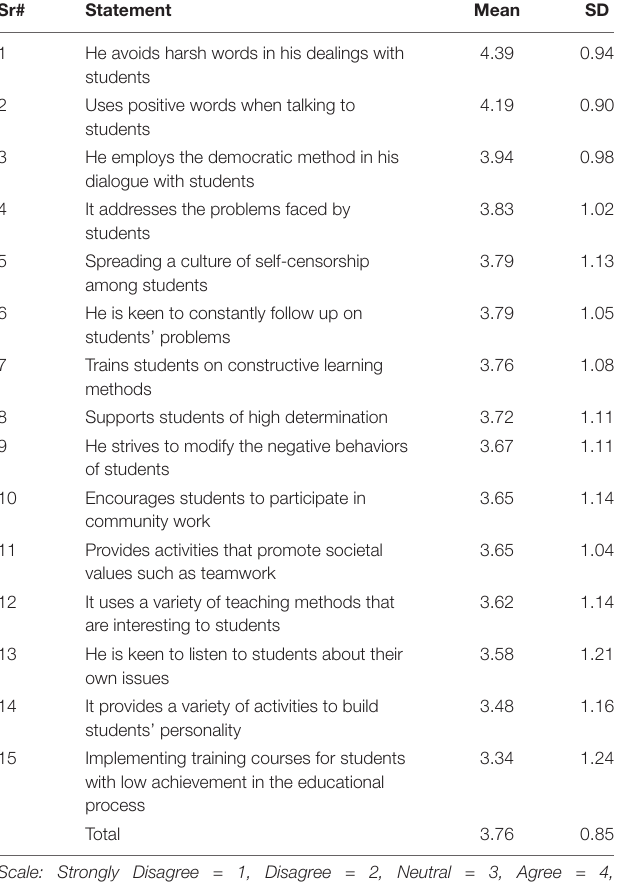
TABLE 3 | Descriptive statistics among faculty member’s field of responsibility toward